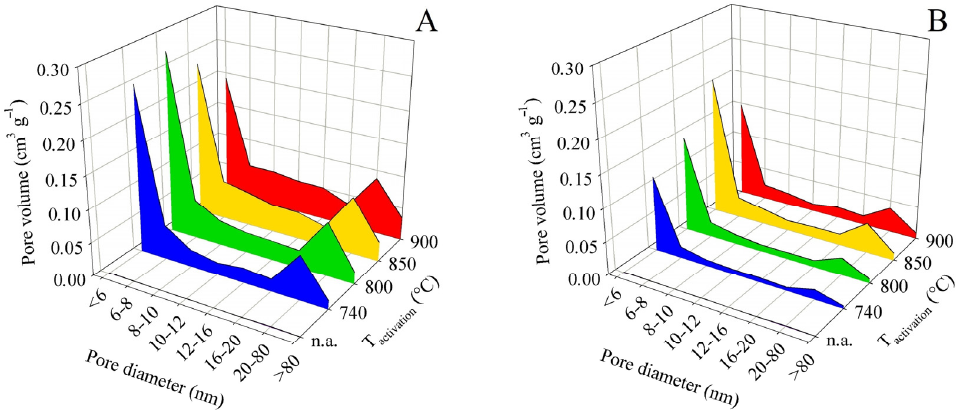
Figure 5. Changes in pore size distribution in dependence on activation conditions applied to the solid residue obtained by pyrolysis up to 450 °C for series ( A , B ).